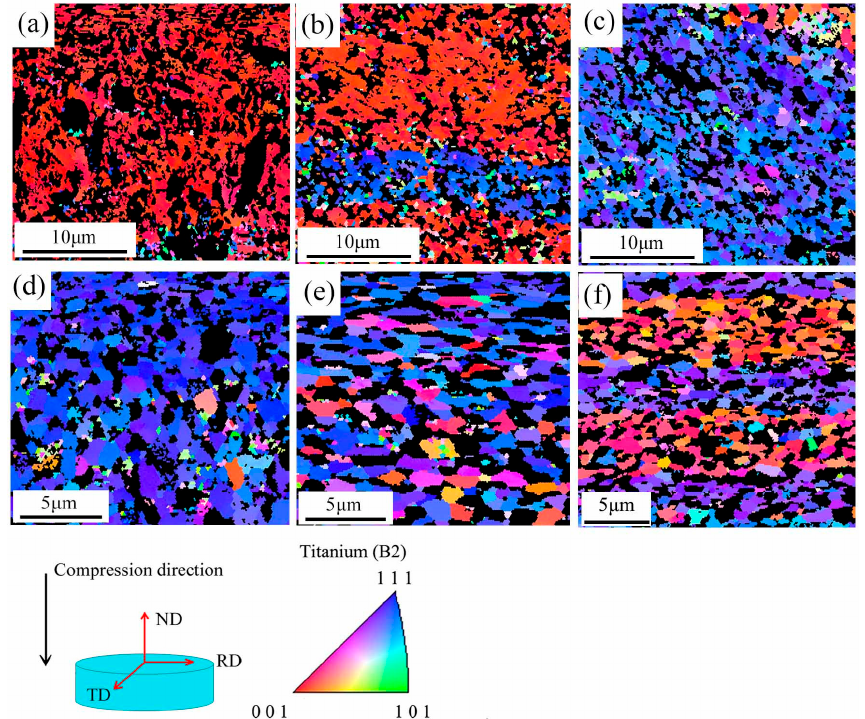
Figure 7. B 2 phase inverse pole figure (IPF) of the as-rolled and can-compressed Ti 2 AlNb samples subject to annealing treatment at 900 ◦ C for 2 h: ( a ) as-rolled, ( b ) 25%, ( c ) 50%, ( d ) 60%, ( e ) 65%, and ( f ) 75%.